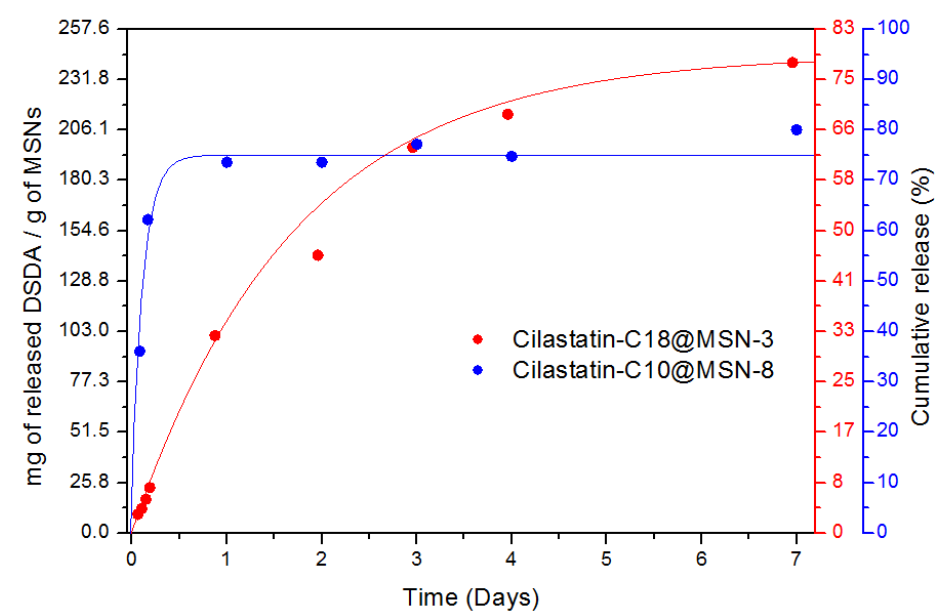
Figure 5. Release experiments of Cilastatin-C18@MSN-3 (red) and Cilastatin-C10@MSN-8 (blue).